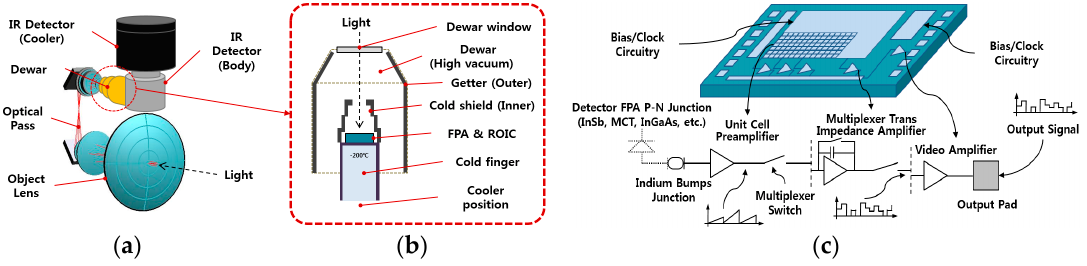
Figure 3. Design example of middle wave IR (MWIR) camera system: ( a ) Optical pass structures, ( b ) example of inner Dewar structures, ( c ) focal plane area (FPA) and readout integrated circuit (ROIC) schematic and electrical diagrams.